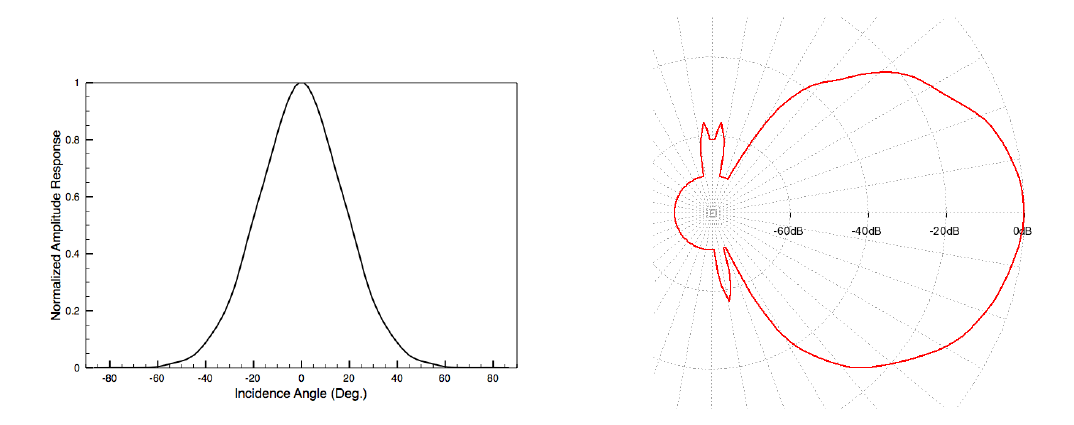
Figure 2. Peak amplitude versus incidence angle using piezo-ceramic ultrasonic transducers. Left: linear plot; Right: polar